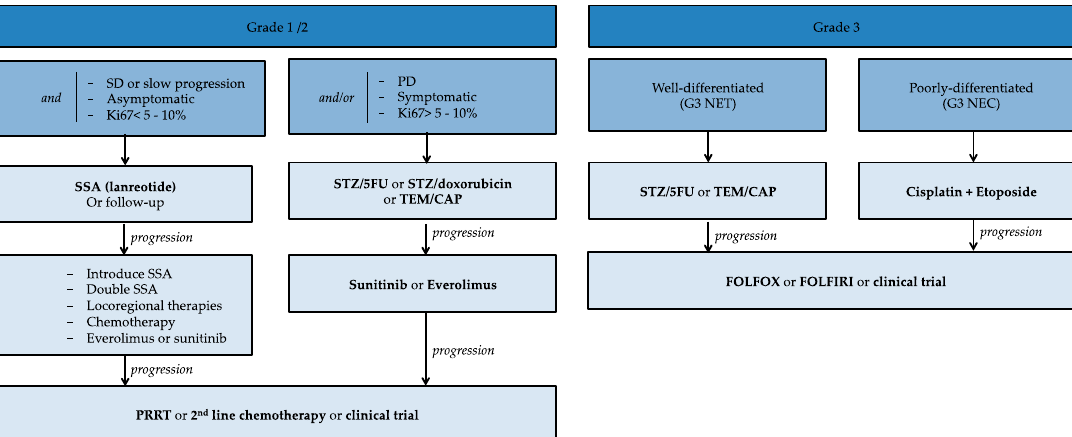
Figure 1. Algorithm for treating advanced pancreatic neuroendocrine tumors. 5FU: 5-fluorouracil; CAP: capecitabine; NEC: neuroendocrine carcinoma; NET: neuroendocrine tumor; PRRT: peptide receptor radionuclide therapy; SD: stable disease; SSA: somatostatin analogs; STZ: streptozotocin; TEM: temodal.